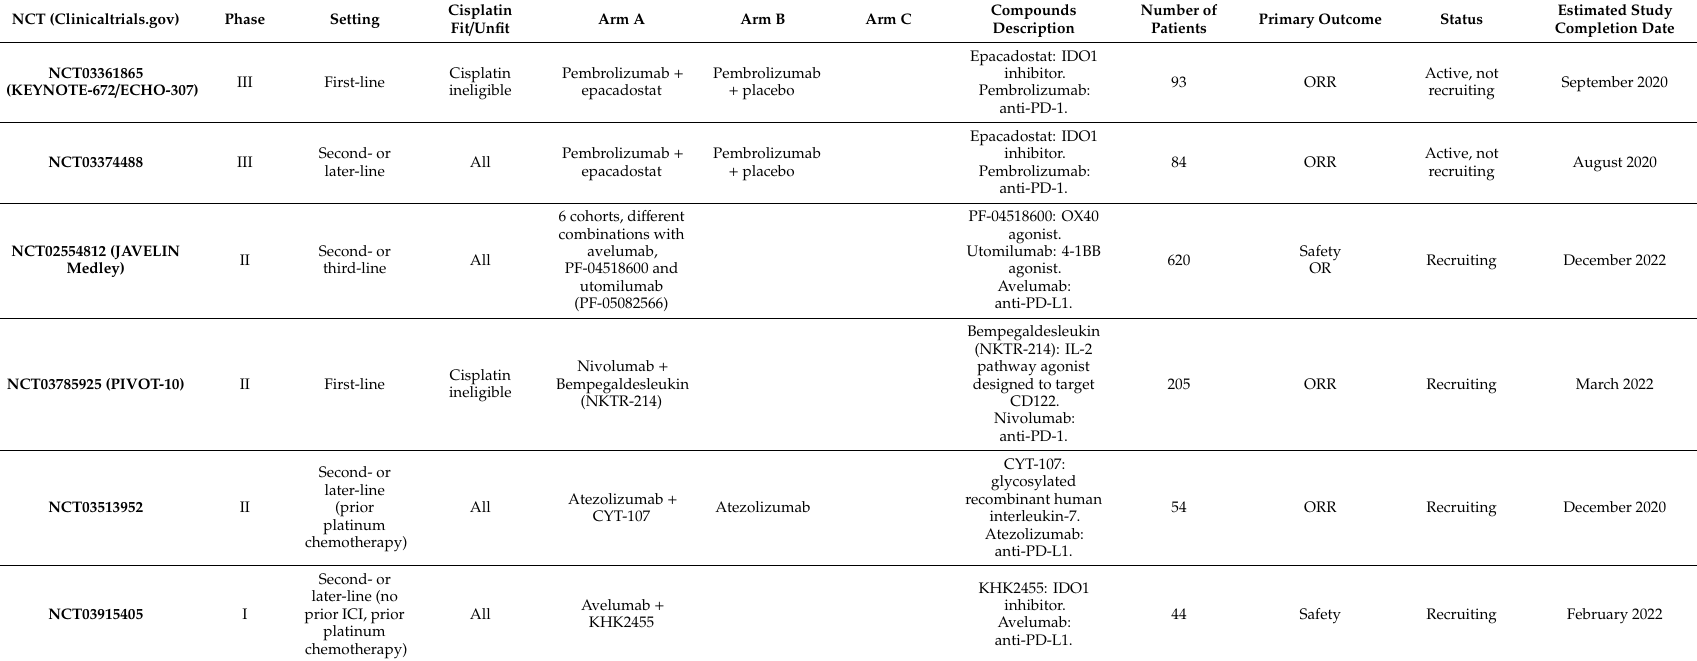
Table 5. Ongoing phase I / II / III trials of novel immunotherapy approaches. ORR: overall response rate. PFS: progression-free survival. OS: overall survival. NCT